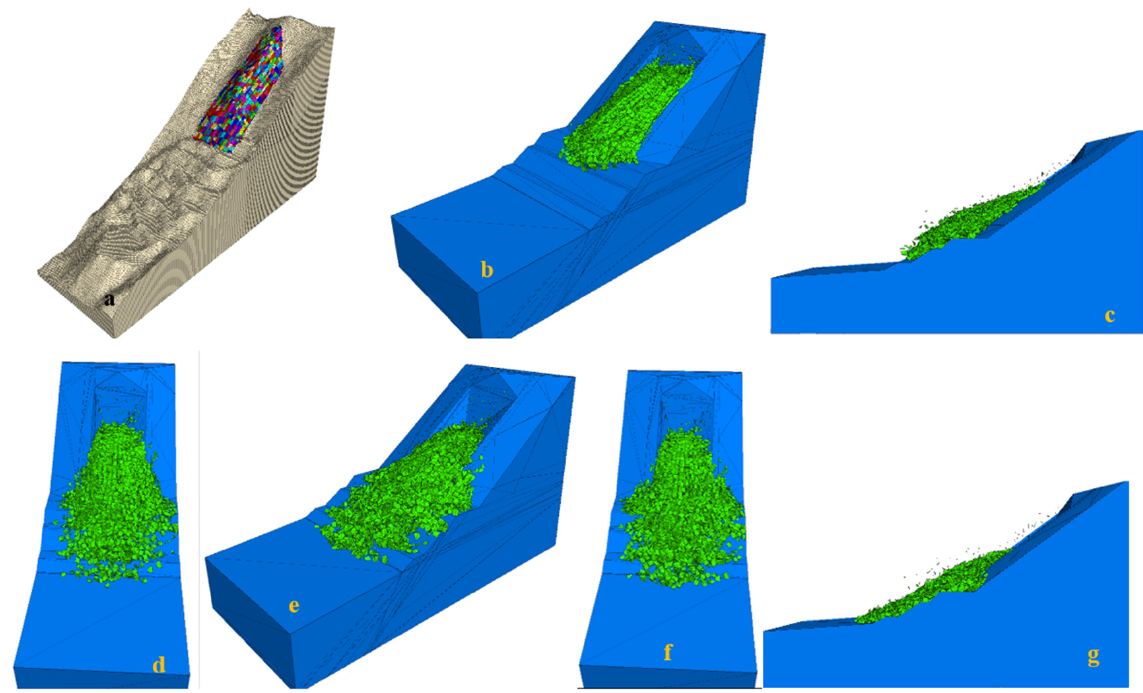
Figure 13. Influence range of landslide mass at different calculation time steps. ( a ) Numerical model. ( b ) T = 10,000. ( c ) T = 13,000. ( d ) T = 16,000. ( e ) T = 19,000. ( f ) T = 22,000. ( g ) T = 28,000.